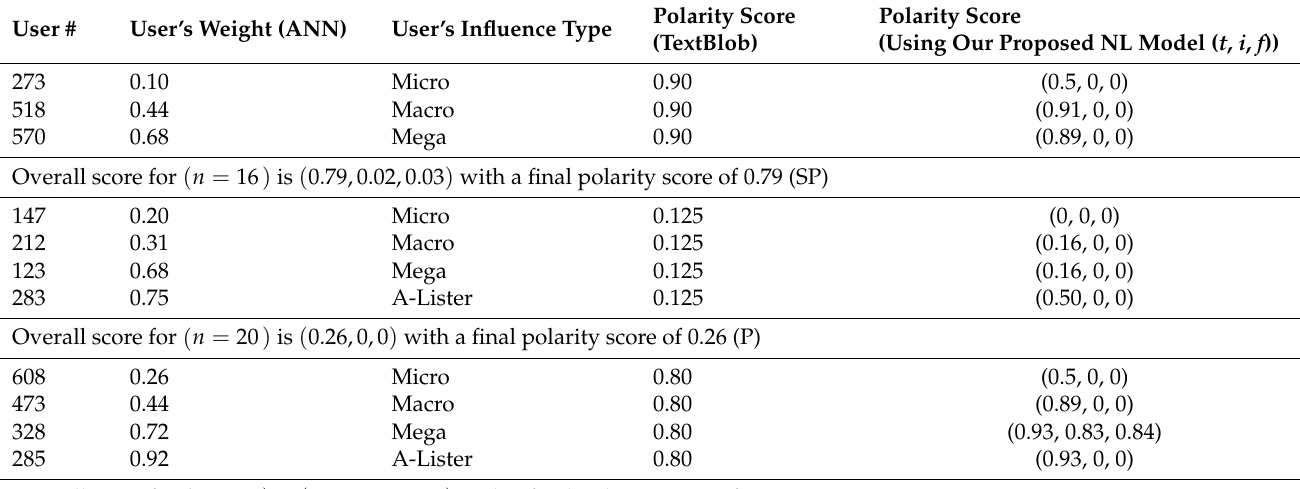
Table 5. Samples of opinion dynamicity in the